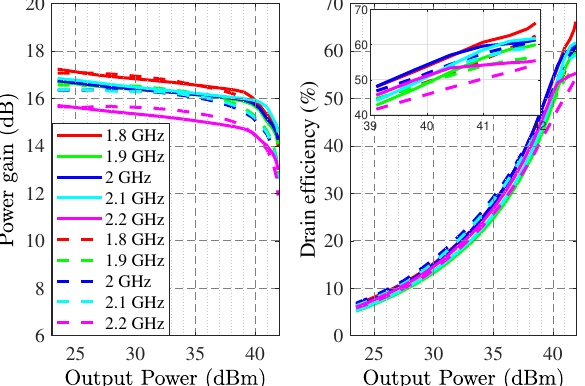
Figure 8. Power gain and drain efficiency over output power simulated (dash lines) and measured (solid lines) at various frequencies.